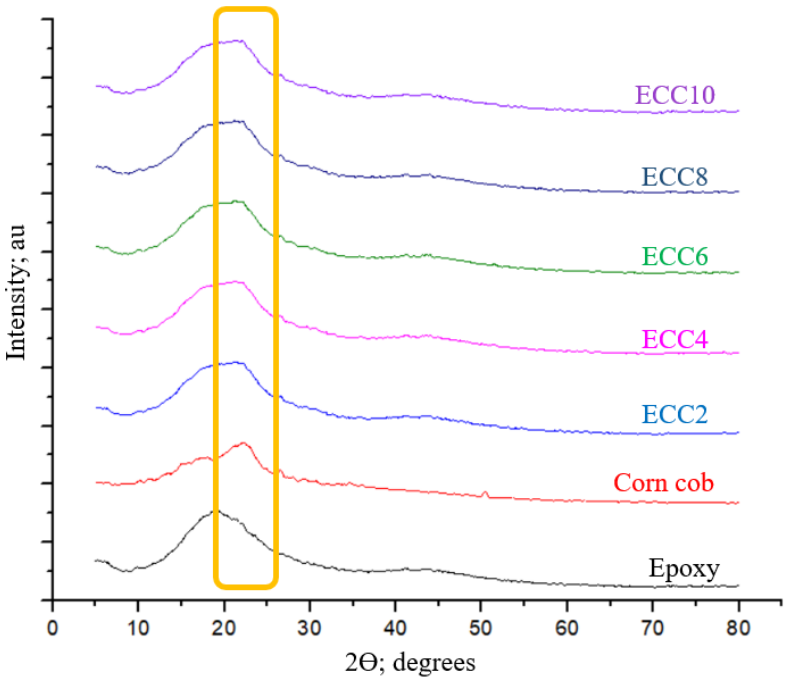
Figure 4. X-ray diffraction (XRD) traces of neat epoxy, corn cob powder, and epoxy composites.